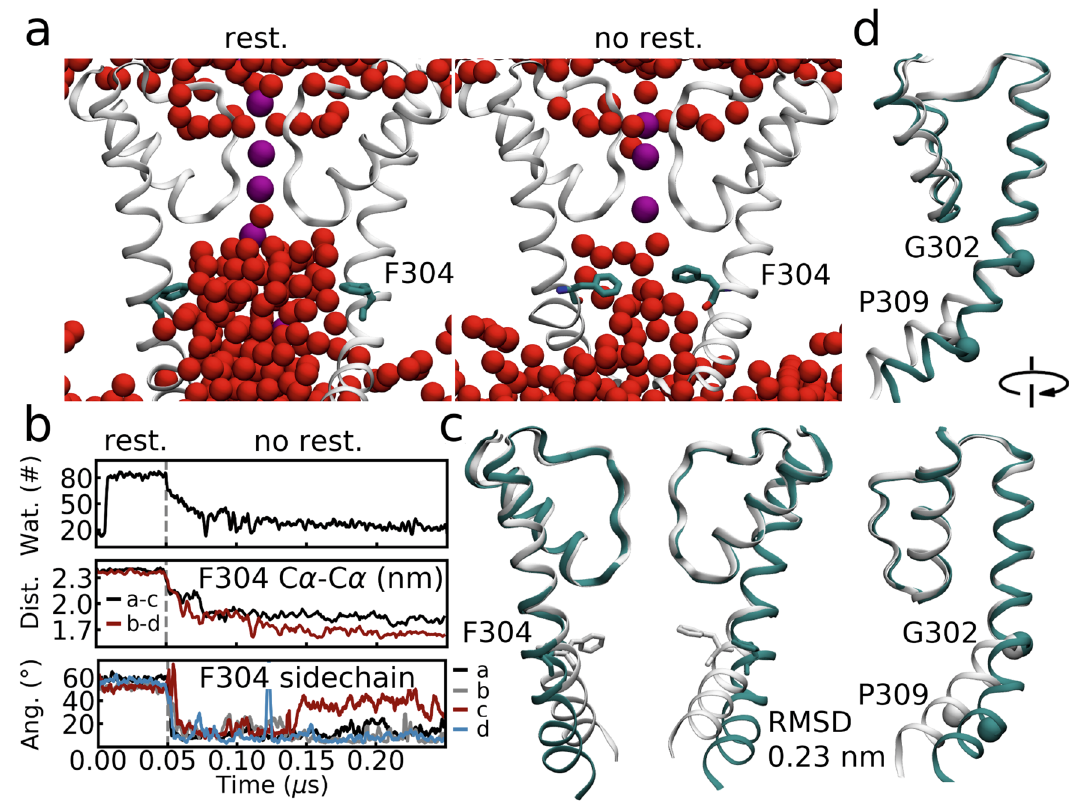
Fig. 3 | Central cavity dehydrated quickly in MD simulations of the closed BK channel.a Cavityhydrationlevelsoftheclosedstateinrestrainedandunrestrained simulations. The F304 side chains are shown in cyan. The water oxygen atoms and potassiumionsareshowninspace fi llingmodelinredandpurple. b Thenumberof watermoleculesincavity,F304C α -C α distance,andF304sidechainorientationas